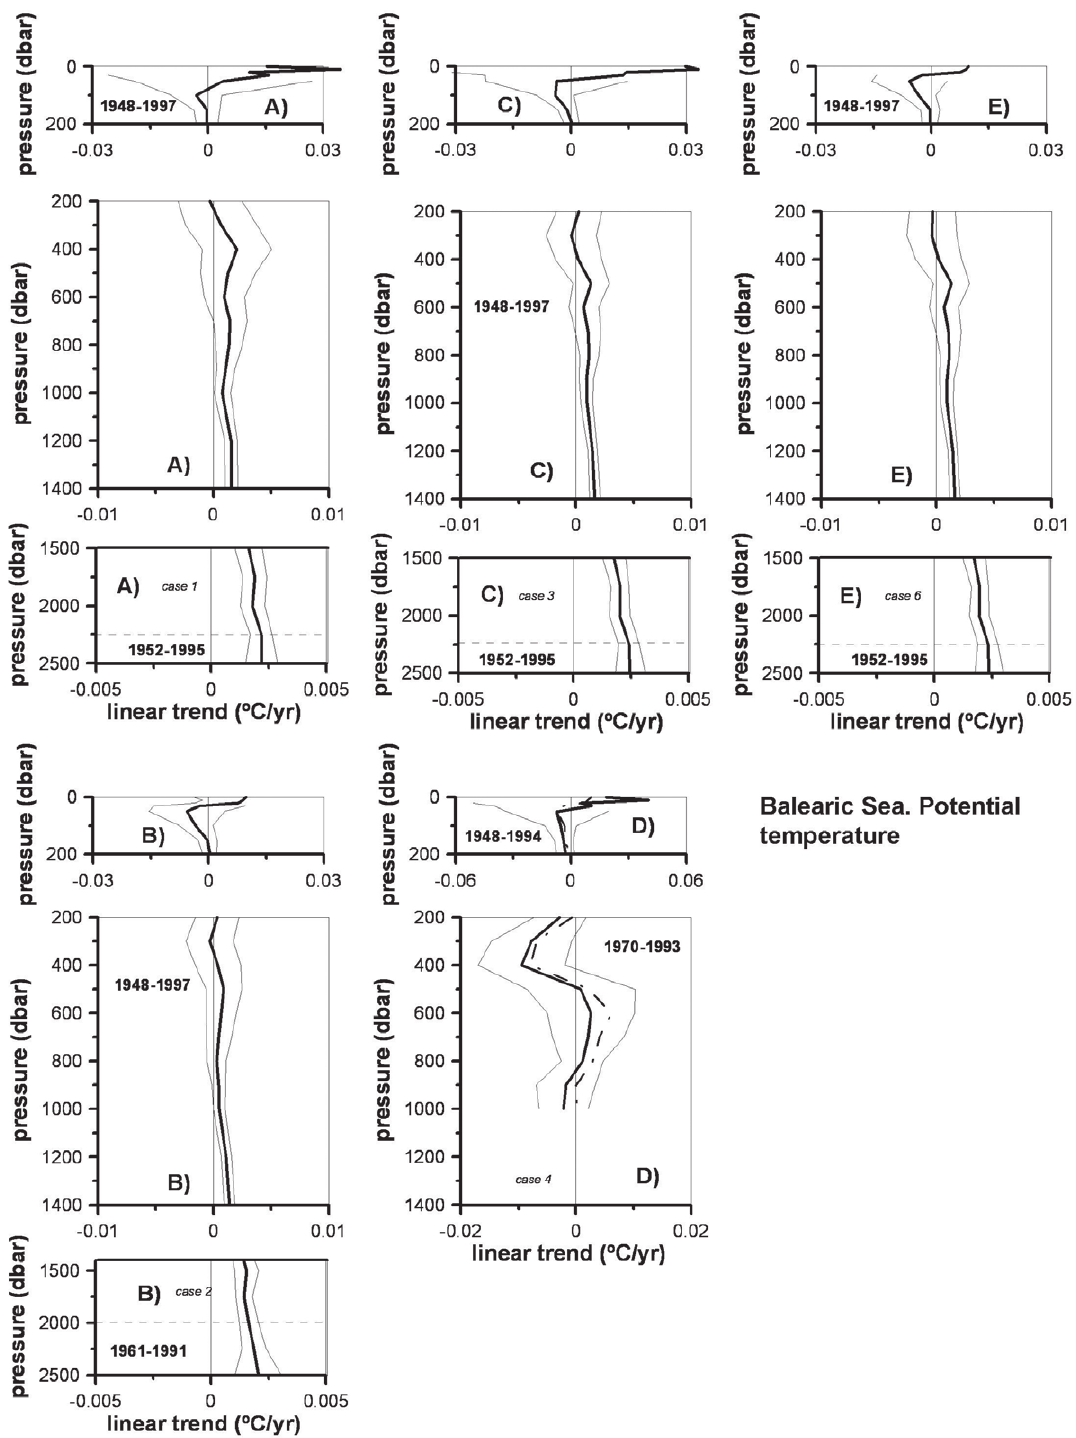
Fig . 8. – as in Figure 6, but for the balearic